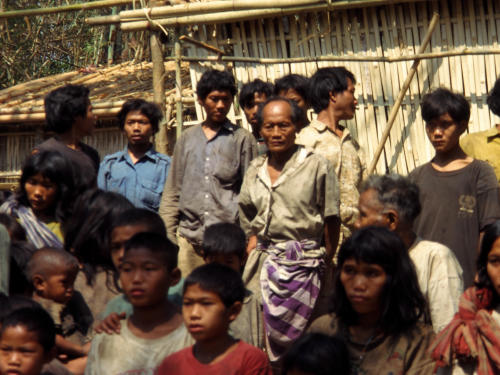
The Mlabri of Thailand: Their history holds a lesson for anthropologists (Photo: Takafumi Ishida)